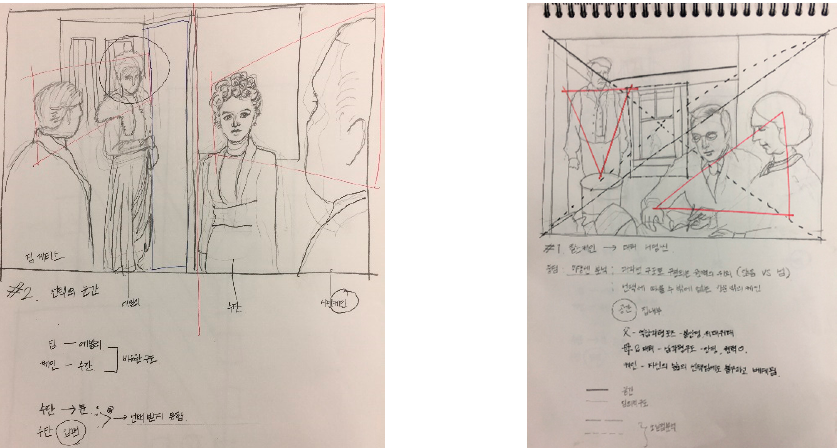
Figure 3. An example of a student’s work: The process of concept development and sketches during the first stage of the two-week drawing workshop.